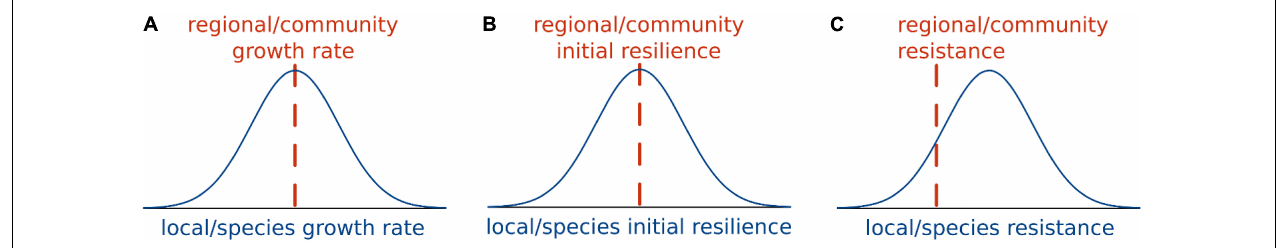
FIGURE 7 | Schematic comparison of different stability components at local or species level vs. at regional or community level, assuming normal distributions for the local and species estimates. The regional or community growth rate (A) and initial resilience (B) is the weighted arithmetic mean of the estimates at the local or species levels. On the contrary, regional/community resistance (C) is the weighted harmonic mean of the local/species estimates, so locations or species with low stability will limit the resistance of spatial or ecological